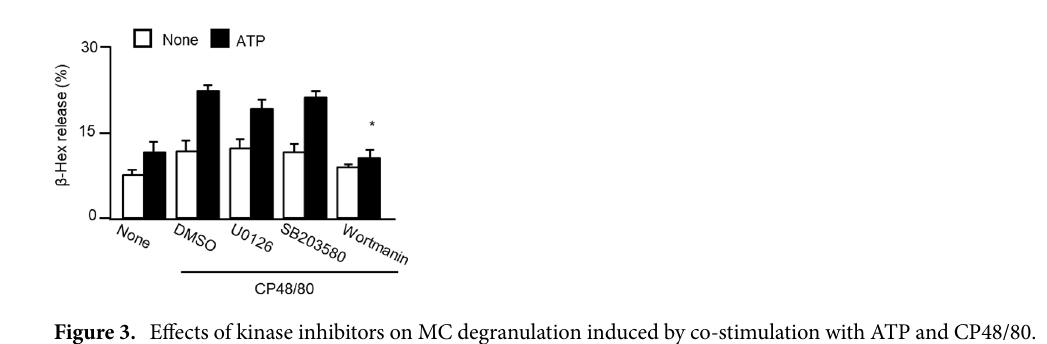
Figure 3. Effects of kinase inhibitors on MC degranulation induced by co-stimulation with ATP and CP48/80. WT PMCs were stimulated with ATP and CP48/80 in the presence or absence of the MEK1/2 inhibitor U0126 (5 μM), p38 MAP kinase inhibitor SB203580 (10 μM), and PI3K inhibitor wortmannin (0.1 μM). The results are presented as the mean ± SEM (n = 3). *P < 0.05 vs DMSO treated ATP plus